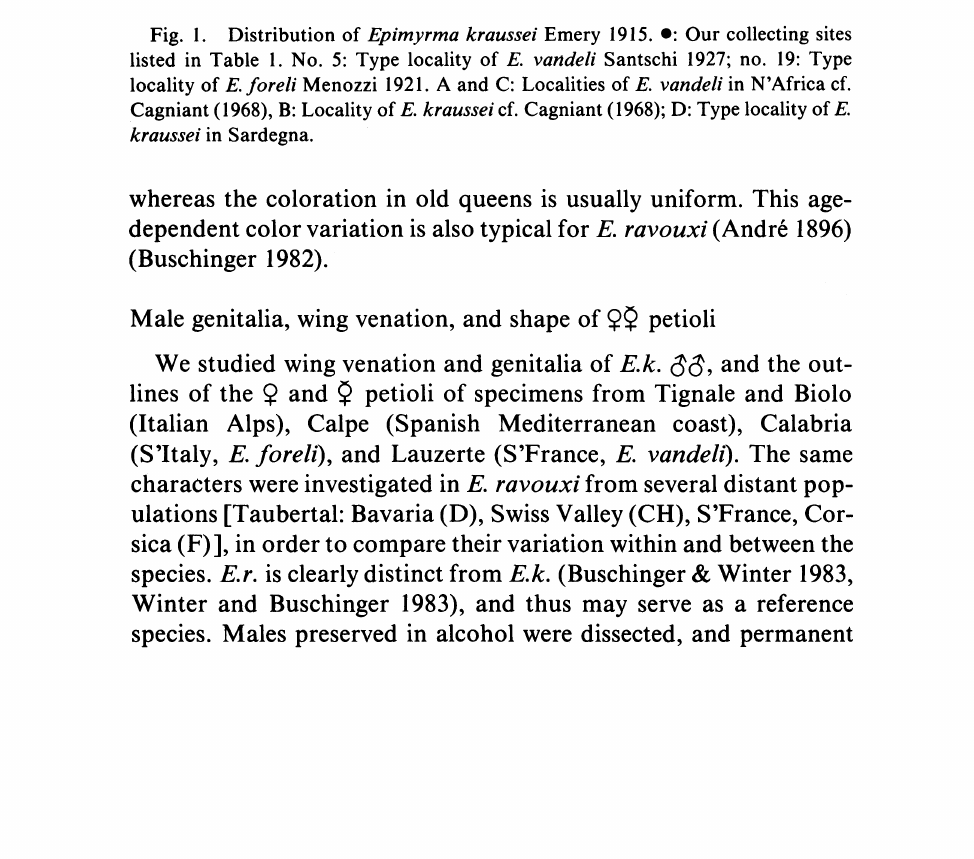
Fig. I. Distribution of Epimyrma kraussei Emery 1915. o: Our collecting sites listed in Table 1. No. 5: Type locality of E. vandeli Santschi 1927; no. 19: Type locality of E. foreli Menozzi 1921. A and C: Localities of E. vandeli in N’Africa cf. Cagniant (1968), B: Locality of E. kraussei cf. Cagniant (1968); D: Type locality of E. kraussei in